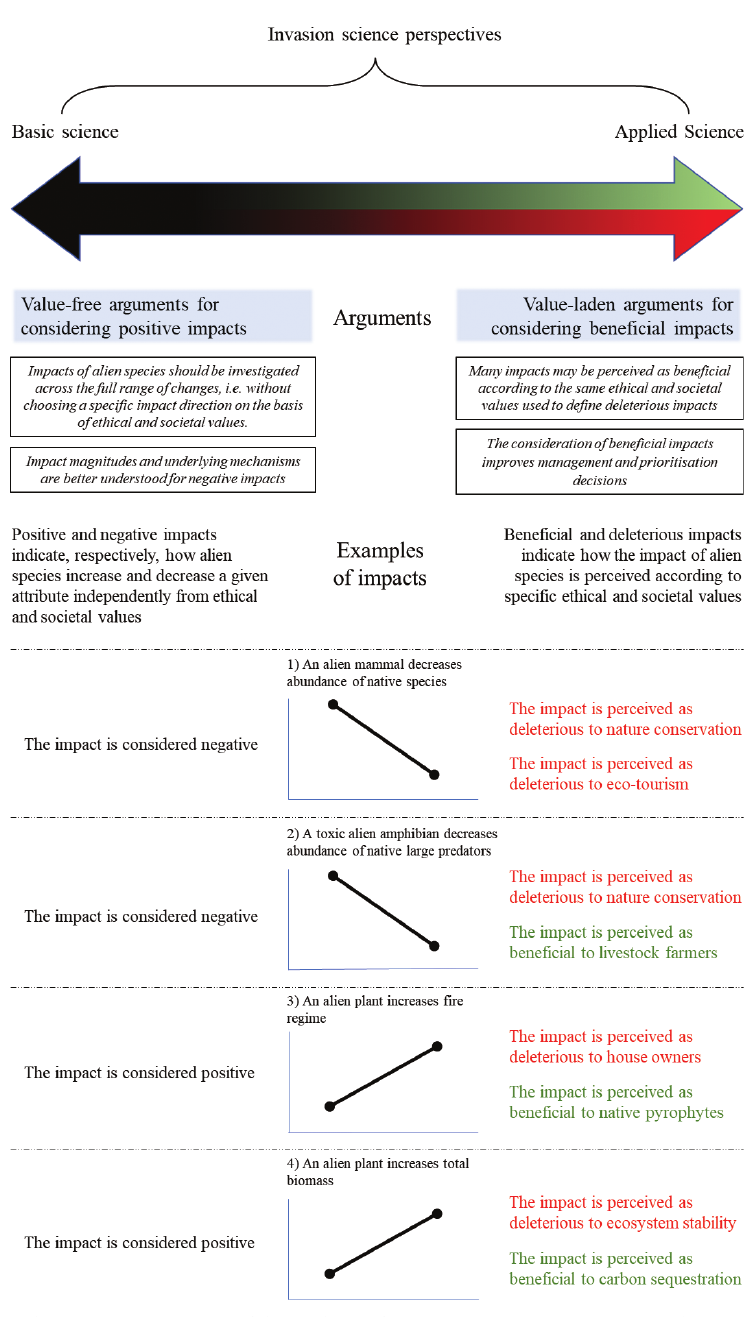
Figure 1. Schematic representation of the gradient of perspectives in invasion science. These perspectives i) contribute to the formulation of general arguments that invoke a greater consideration of positive and beneficial impacts; ii) help to distinguish between negative/positive impacts and deleterious/beneficial impacts. Four examples (1–4) are also provided to illustrate a conceptual distinction between positive/ negative impacts (black text) and beneficial/deleterious impacts (red and green